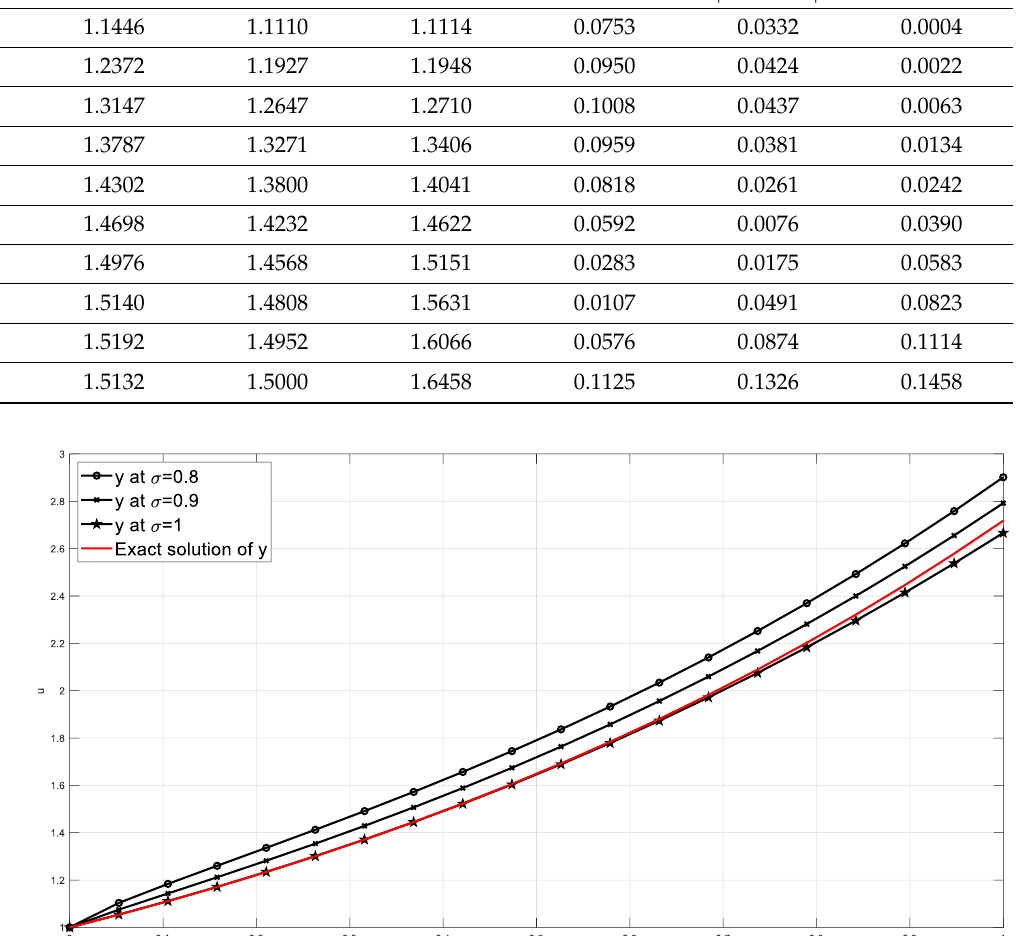
Table 1. Values of the approximate and exact solutions of Equation (19) at di ff erent values of 𝓉 .